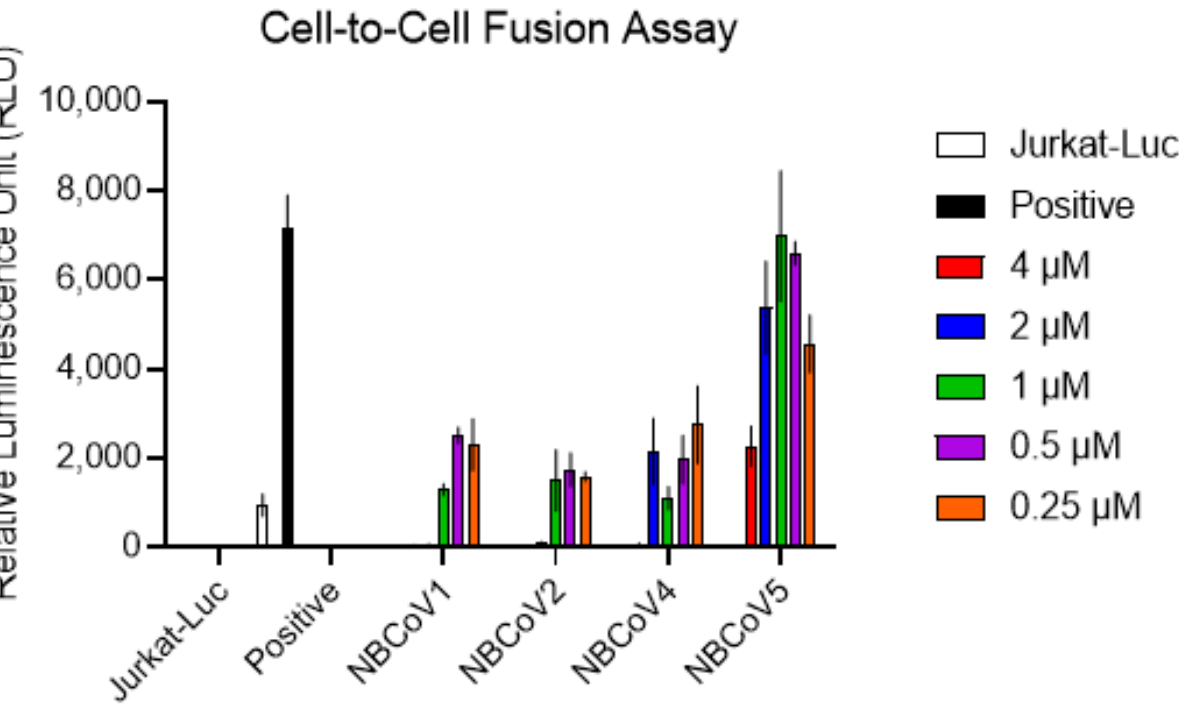
Figure 4. SARS-CoV-2 mediated cell-to-cell fusion inhibition assay. Jurkat cells expressing the SARS-CoV-2 full Spike wild-type gene from Wuhan-Hu-1 isolate and the luciferase gene were used as donor cells and the 293T/ACE2 as acceptor cells. Jurkat cells were preincubated for 1 h with different concentrations of NBCoV small molecules. Positive represent 293T/ACE2 cells cocultured with Jurkat cells in the absence of NBCoVs. Jurkat-Luc represents 293T/ACE2 cells cocultured with Jurkat cells expressing the luciferase gene only, in the absence of NBCoVs. Columns represent the means ± standard deviations ( n = 2–4).